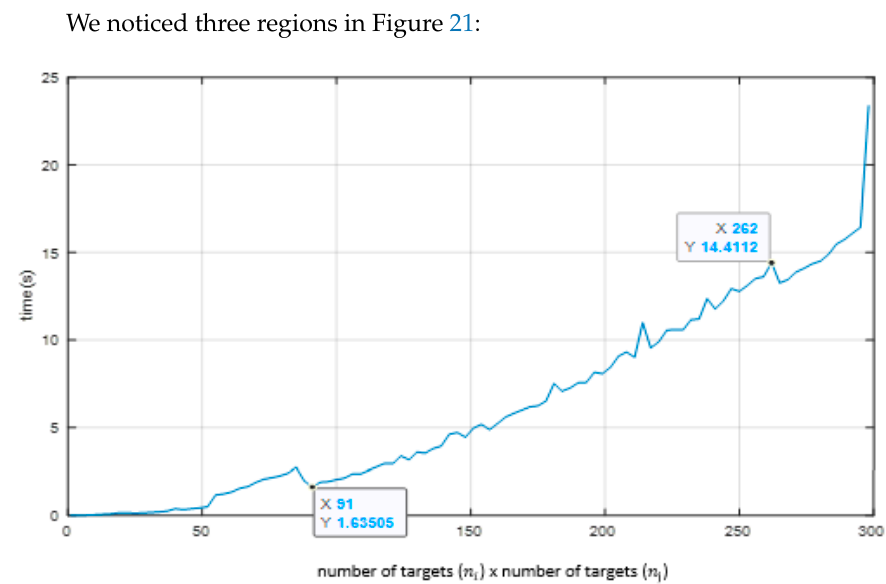
UT computation: 3D position measurement mean and covariance obtained at a k c capture instant of the i -th camera.